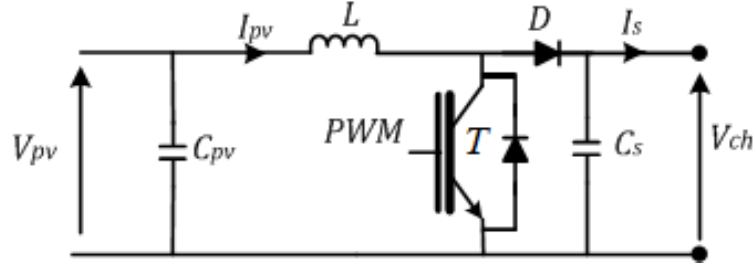
Figure 5. Block diagram of the Boost DC/DC